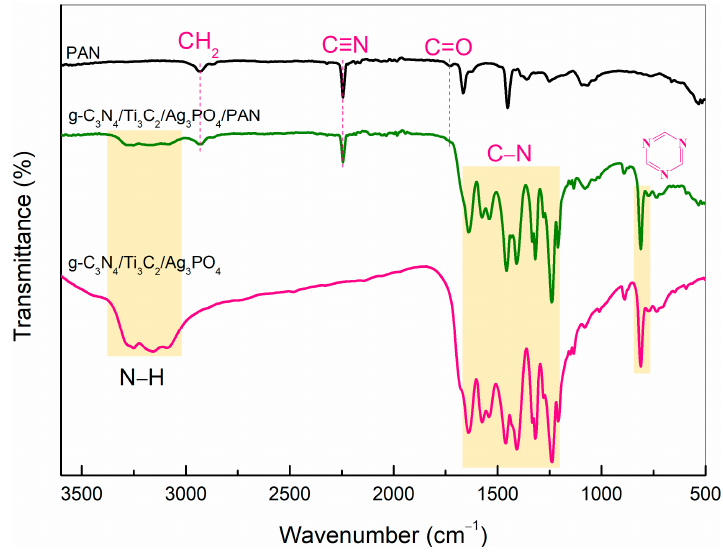
Figure 1. FTIR spectra of PAN, g-C 3 N 4 /Ti 3 C 2 /Ag 3 PO 4 and g-C 3 N 4 /Ti 3 C 2 /Ag 3 PO 4 /PAN.